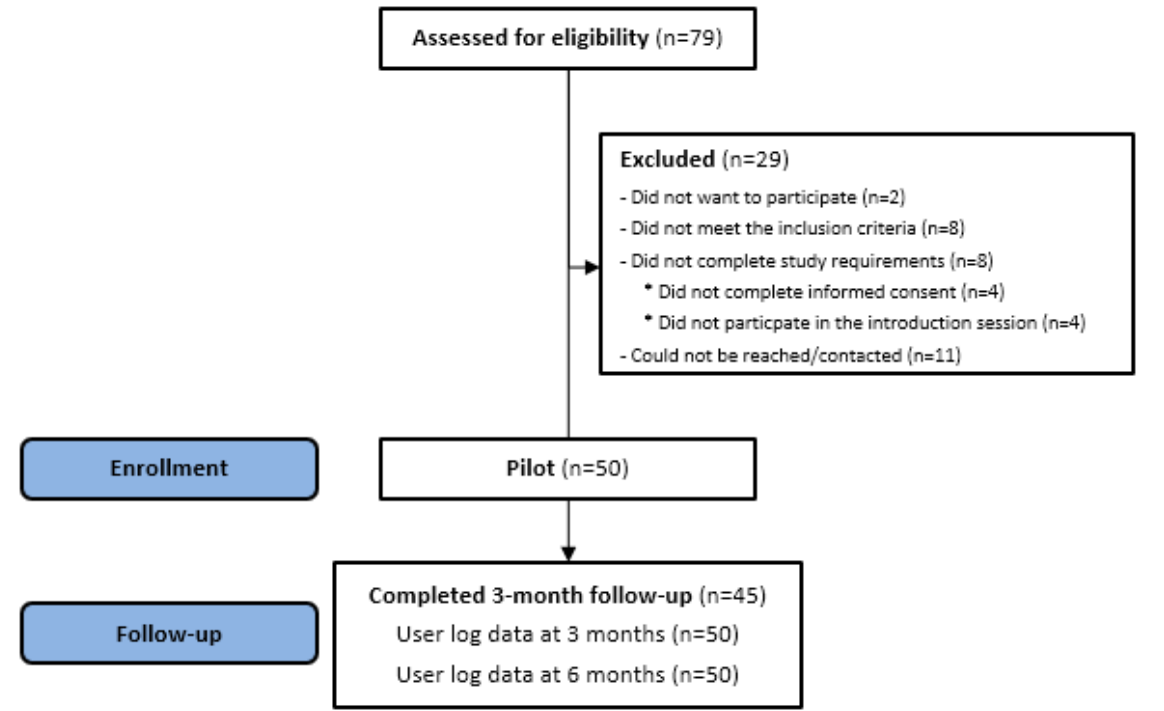
Figure 1. Recruitment and participant